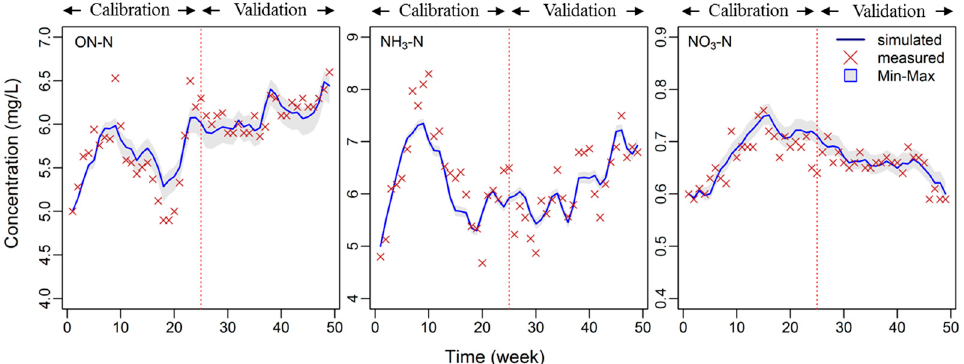
Figure 3. Weekly time series of observed and simulated ammonia nitrogen (NH 3 -N), organic nitrogen (ON-N), and Nitrate (NO 3 -N) during a one-year calibration and validation period from 2014–2015. Sensitivity ranges of weekly ON, NH 3 , and NO 3 were generated with the Markov chain Monte Carlo (MCMC) application. Gray shading indicates minimum and maximum model responses at each time step.